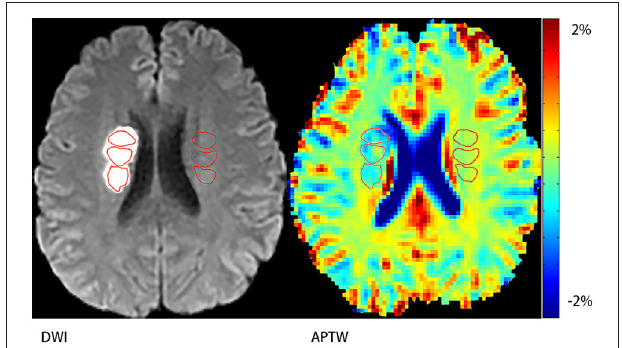
FIGURE 1 | Demonstration of regions of interest (ROIs). Three ROIs on the stroke hemisphere within the stroke area defined by DWI and another three ones on the contralateral